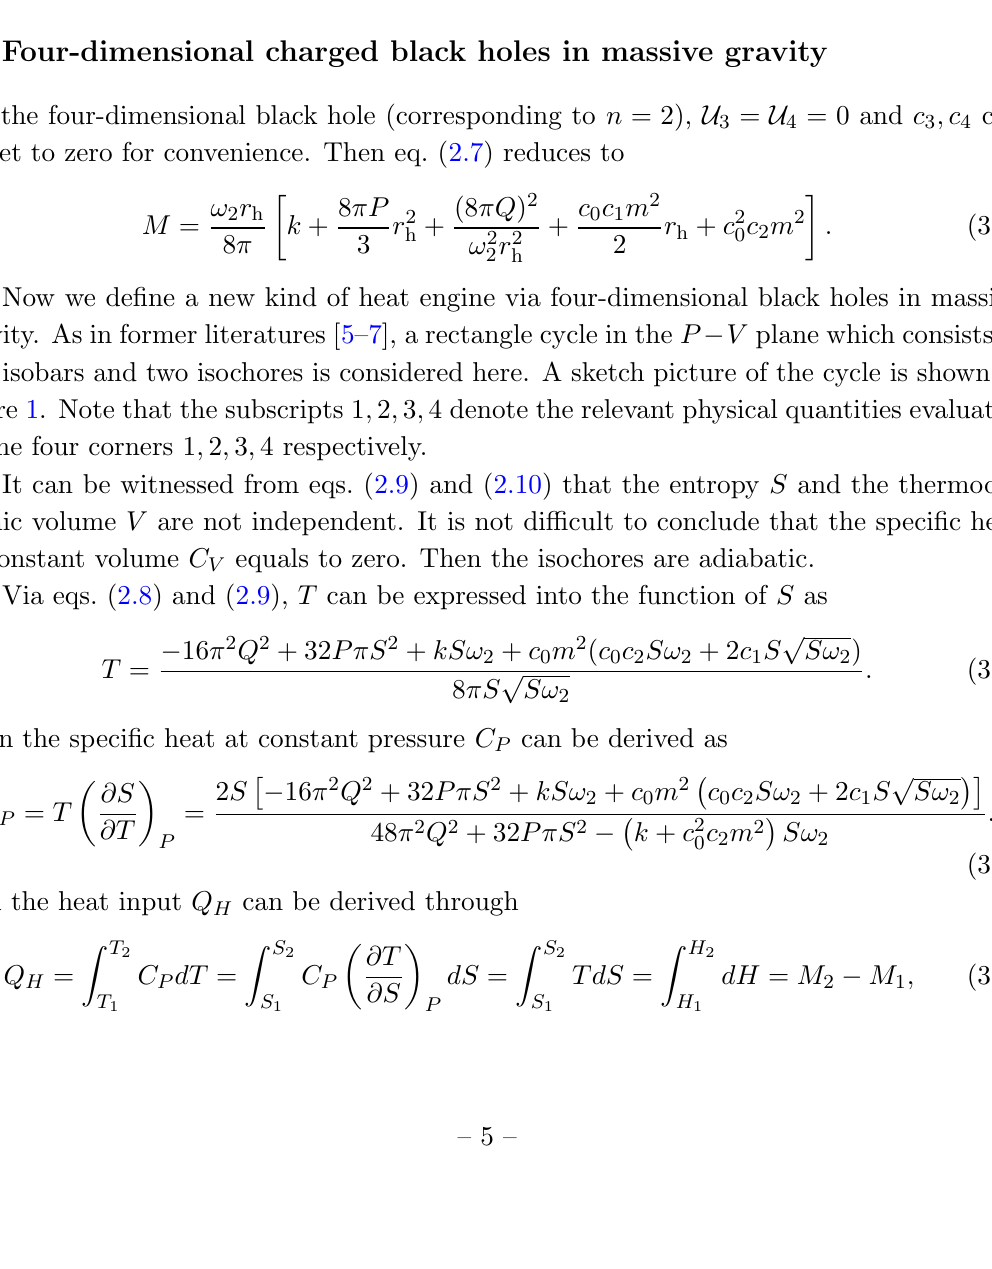
Figure 1 . The heat engine cycle